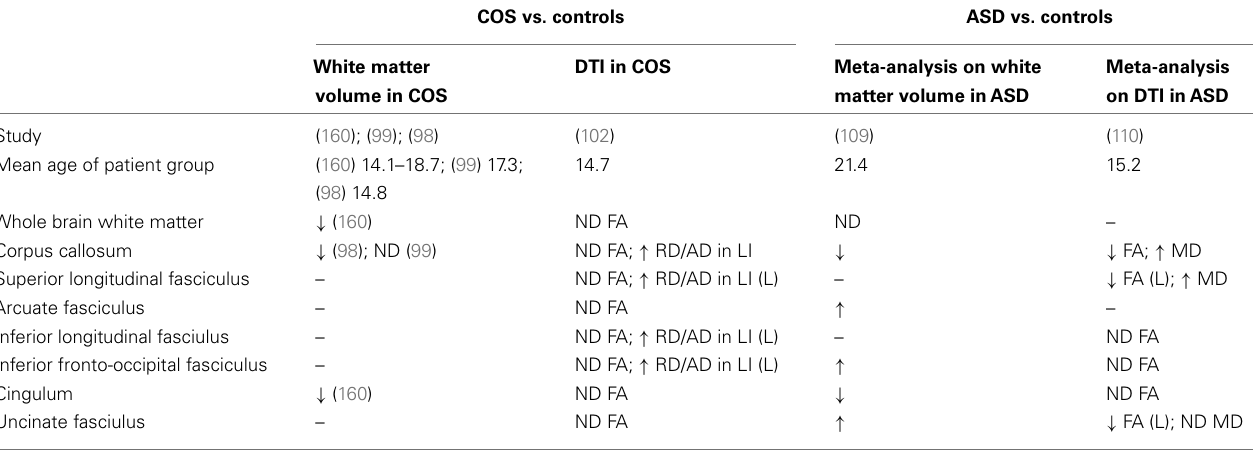
Table 1 | Summary of white matter findings inASD and COS .